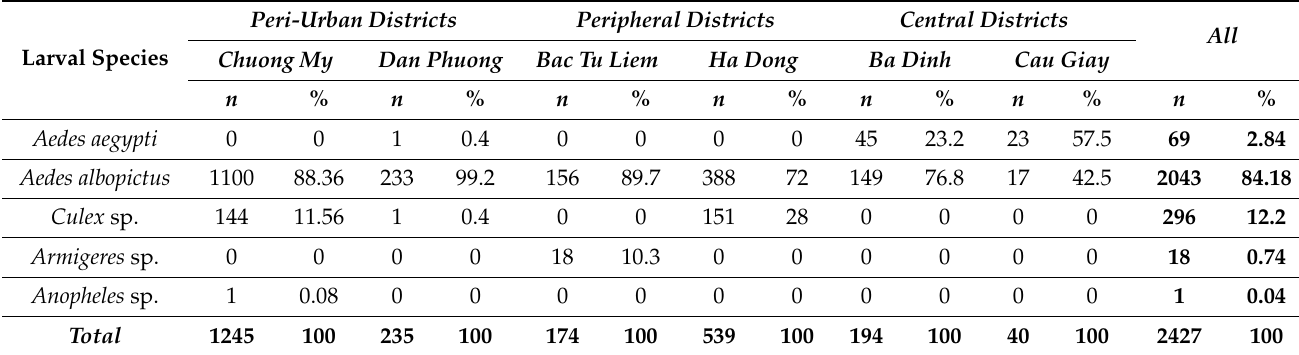
Table 5. Distribution of larvae species by collection